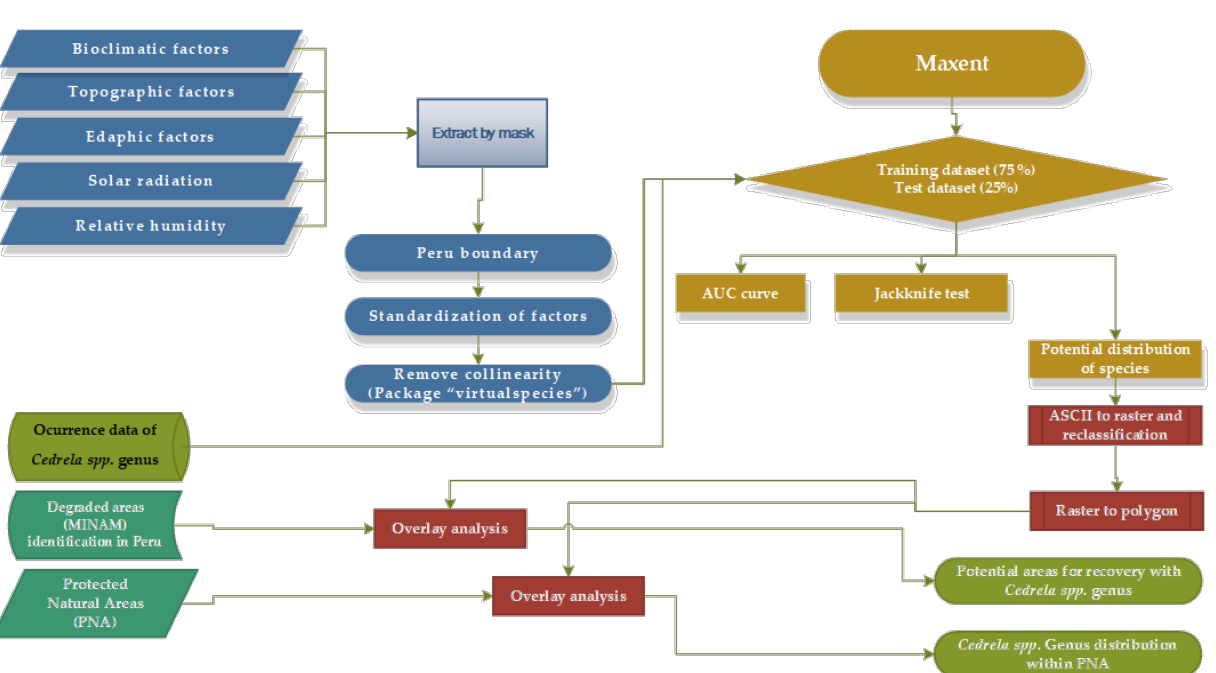
Figure 2. Methodological process for the biogeographic modeling of the genus Cedrela in Peru.